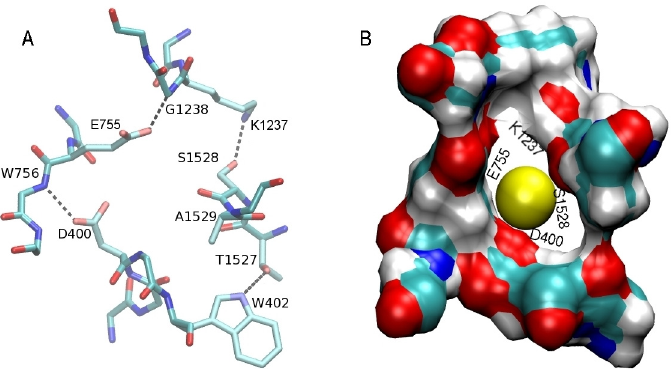
Fig 3. Structure of the SF. (A) Inter-domain linking interactions in SF of the Na V 1.4 channel. (B) Space-filling diagram of the SF. The atoms facing the pore in the DEKA locus are indicated with labels. These are the side chain O atoms of D400 and E755, the backbone O atom of S1528, and the C α atom of K1237. The O – O distances are; 5.9 Å for D-E, 5.5 Å for E-S, and 5.6 Å for